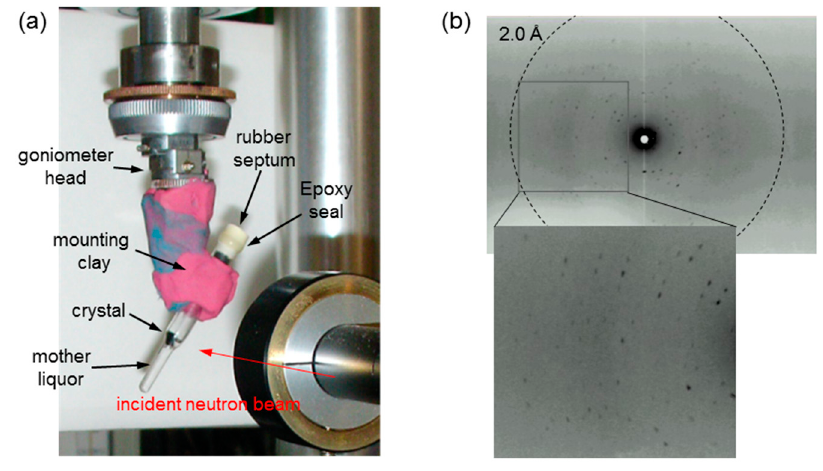
Figure 5. NC measurement for the T-state deoxyHbA crystal. ( a ) Experimental setup; ( b ) Typical neutron diffraction pattern of the deoxyHbA crystal. The dashed circle represents the resolution at 2.0 Å. The picture below is a close up view.